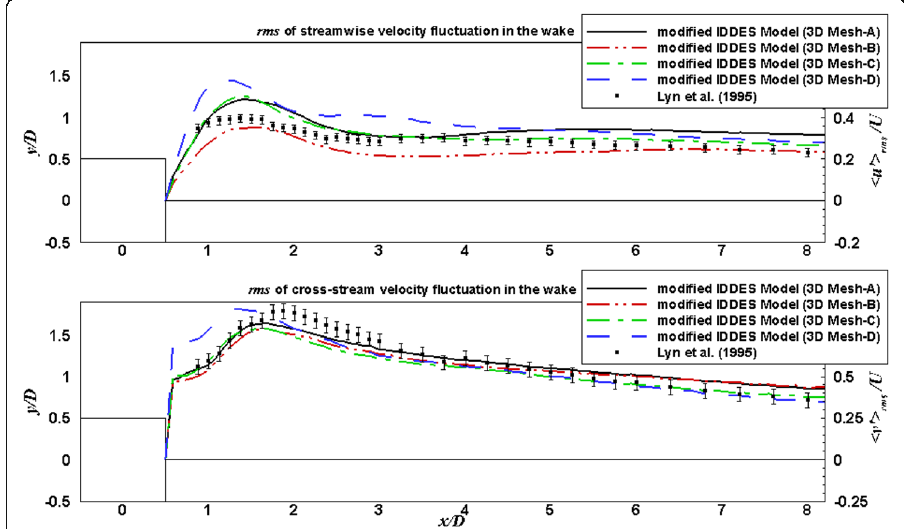
Fig. 16 rms streamwise (top) and cross-stream (bottom) velocity fluctuations along the wake centerline predicted by 3D simulations with the modified IDDES model